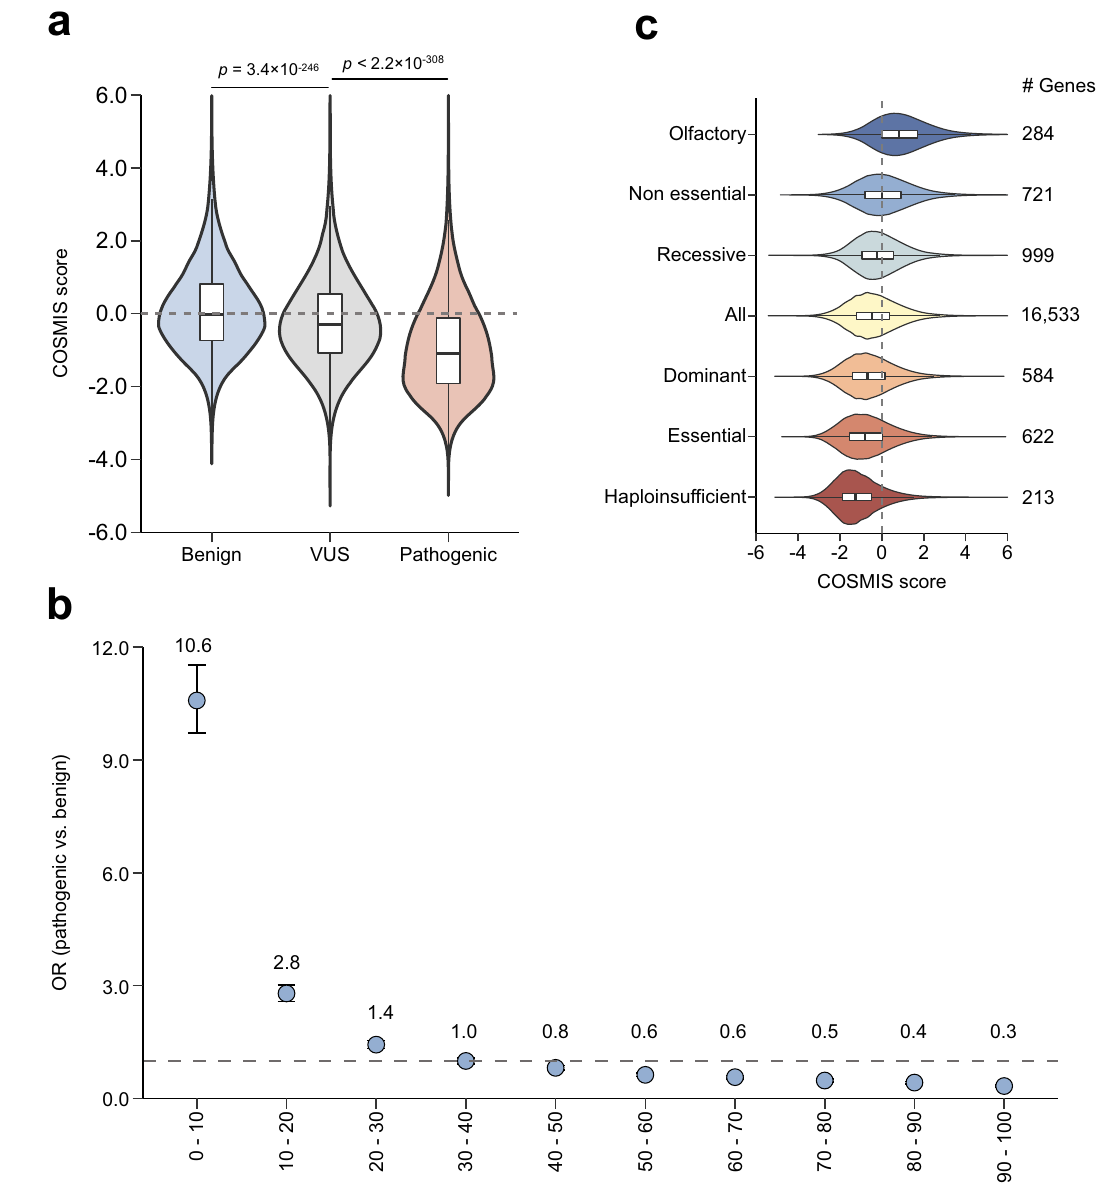
Fig. 5 The COSMIS score is strongly correlated with both pathogenicity and gene constraint level. a COSMIS score distributions for 19,346 benign, 14,824 pathogenic, and 115,172 VUS sites from ClinVar (Methods). Pathogenic variants have signi fi cantly more constrained 3D spatial neighborhoods (COSMIS score median − 1.1) than benign variants (median score 0.0) ( p < 2 : 2 ´ 10 (cid:1) 308 , two-sided Mann – Whitney U test). In boxplot graphs center line indicates median, bounds of box indicate 25th and 75th percentiles, and whiskers indicate minimum and maximum. b Odds ratio of ClinVar pathogenic variants versus benign variants for different COSMIS score percentile bins (lower bins correspond to more constrained COSMIS scores). Amino acid sites with lower COSMIS scores are enriched for pathogenic variants whereas sites with higher scores are depleted of pathogenic variants. Error bars indicate 95% con fi dence intervals. The horizontal dashed line indicates OR = 1. The values for each cell of the contingency table used for the OR calculation in each percentile bin were reported in Supplementary Data 14. c COSMIS score distributions of amino acid sites in six groups of proteins encoded by genes with different functional annotations (and the dataset as a whole). As the anticipated functional constraint on each category increases (top-to-bottom), amino acid sites in proteins in the category have more constrained COSMIS scores on average. In boxplot graphs center line indicates median, bounds of box indicate 25th and 75th percentiles, and whiskers indicate minimum and maximum. OR odds ratio, VUS variants of uncertain signi fi cance. Source data are provided as a Source Data fi the highest Spearman ’ s ρ between a phylogenetic metric and an that both groups of metrics demonstrated predictive ability for intraspecies constraint score (i.e., 0.38, ConSurf vs. RVIS and variant pathogenicity (Fig. 6a and Supplementary Fig. 12), this Missense_Z). This is consistent with previous fi nding that suggests that these two groups of metrics contain complementary intraspecies constraint metrics are only modestly correlated with information that, when combined, could improve performance in phylogenetic conservation 16,17 . Together with the observation predicting variant pathogenicity.